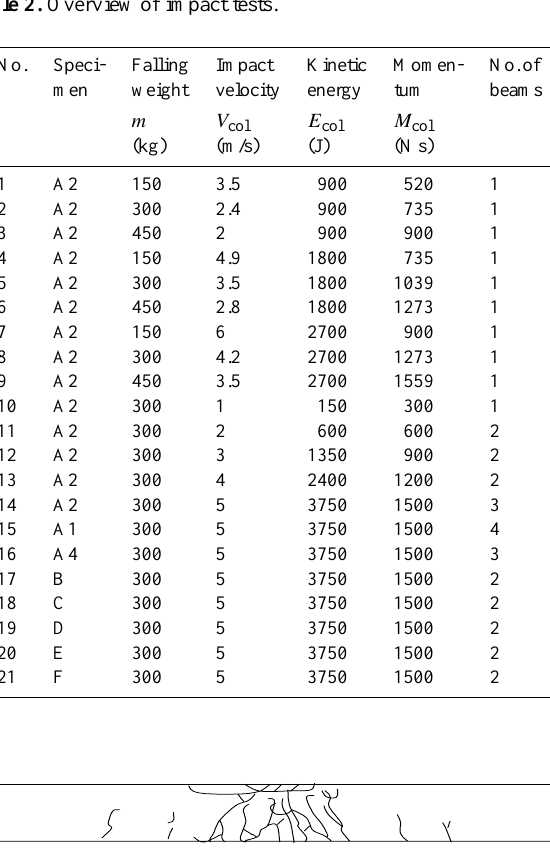
Table 3. Experimental